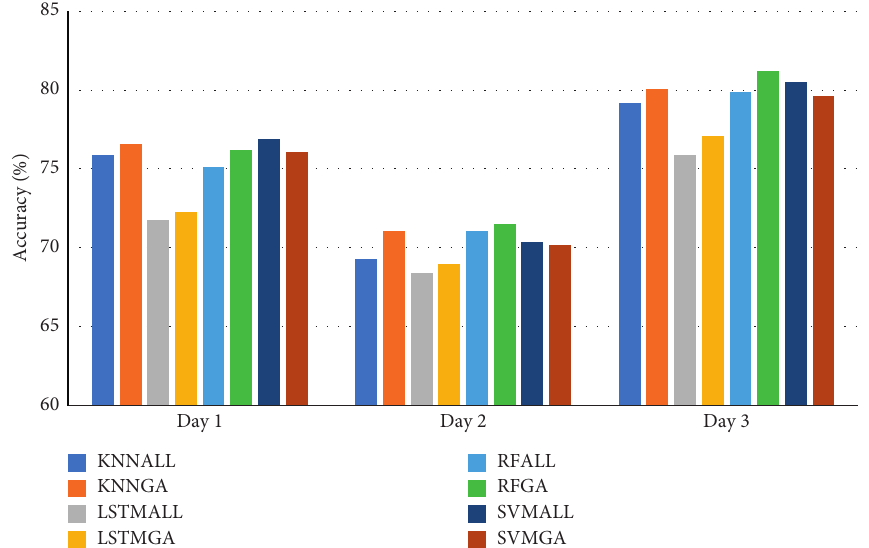
Figure 6: The prediction accuracy of models for three random days.